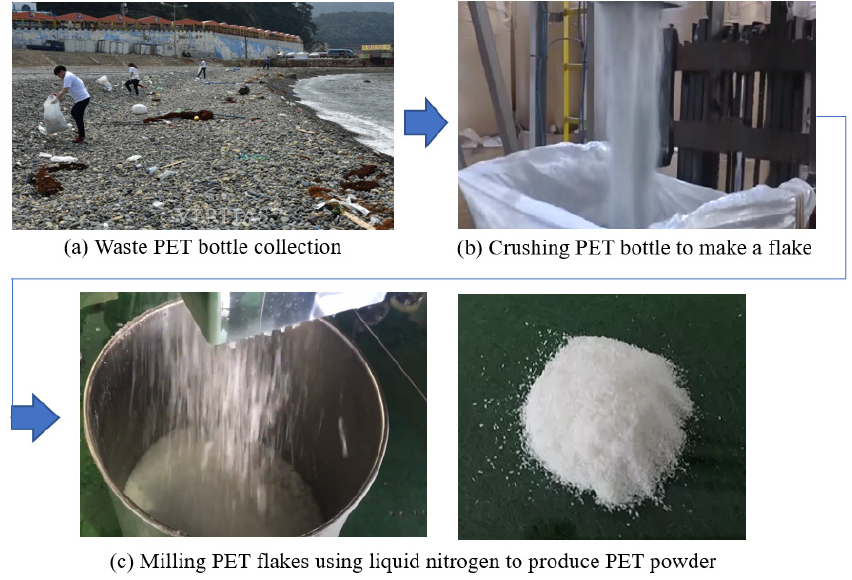
Figure 1. Preparation process of PET powder. ( a ) Waste PET bottle collection; ( b ) crushing PET bottle to make a flake; ( c ) Milling PET flakes using liquid nitrogen to produce PET powder. Table 1. Oxide composition (%) of the cement obtained by XRF spectroscopy